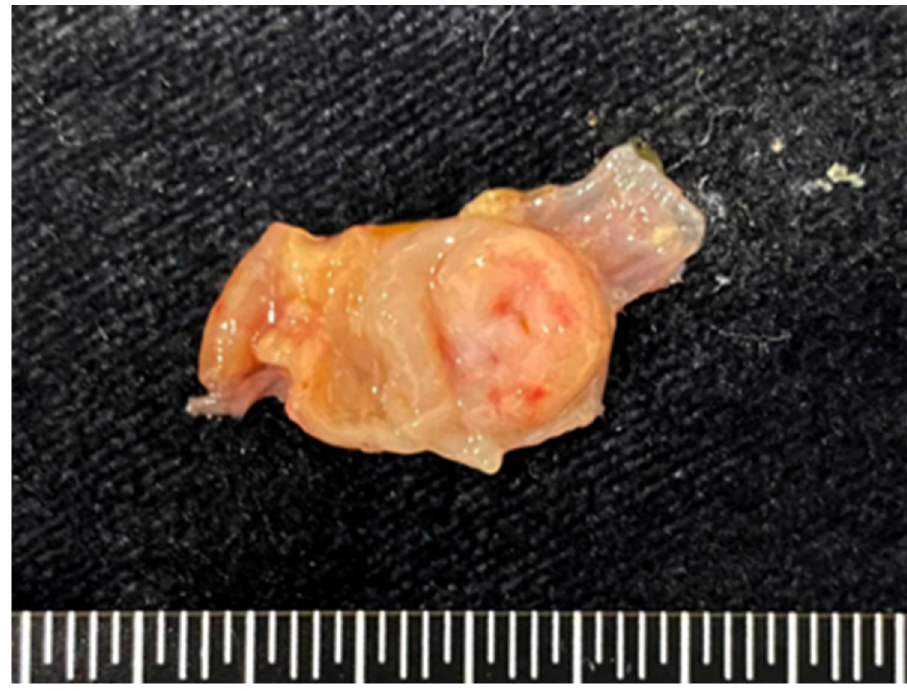
Figure 3. Gastric mast cell tumor, African dormouse, Stomach. A locally extensive, pale, thickened mucosal foci occupy the cardia to the body of the stomach.